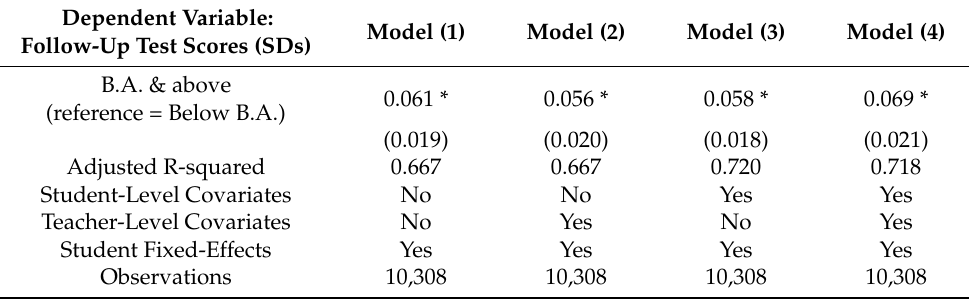
Table 7. Effect of teacher educational attainment on student learning